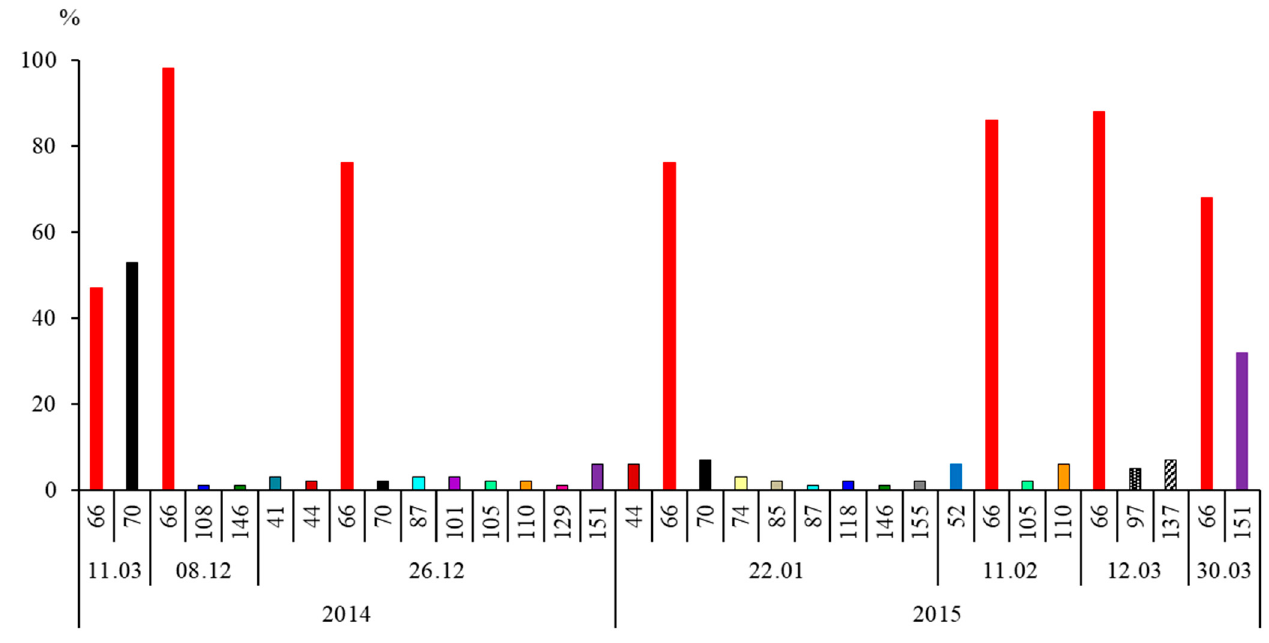
Figure 4. Relative content of PCB congeners in solid precipitations in the territory of Almaty city.